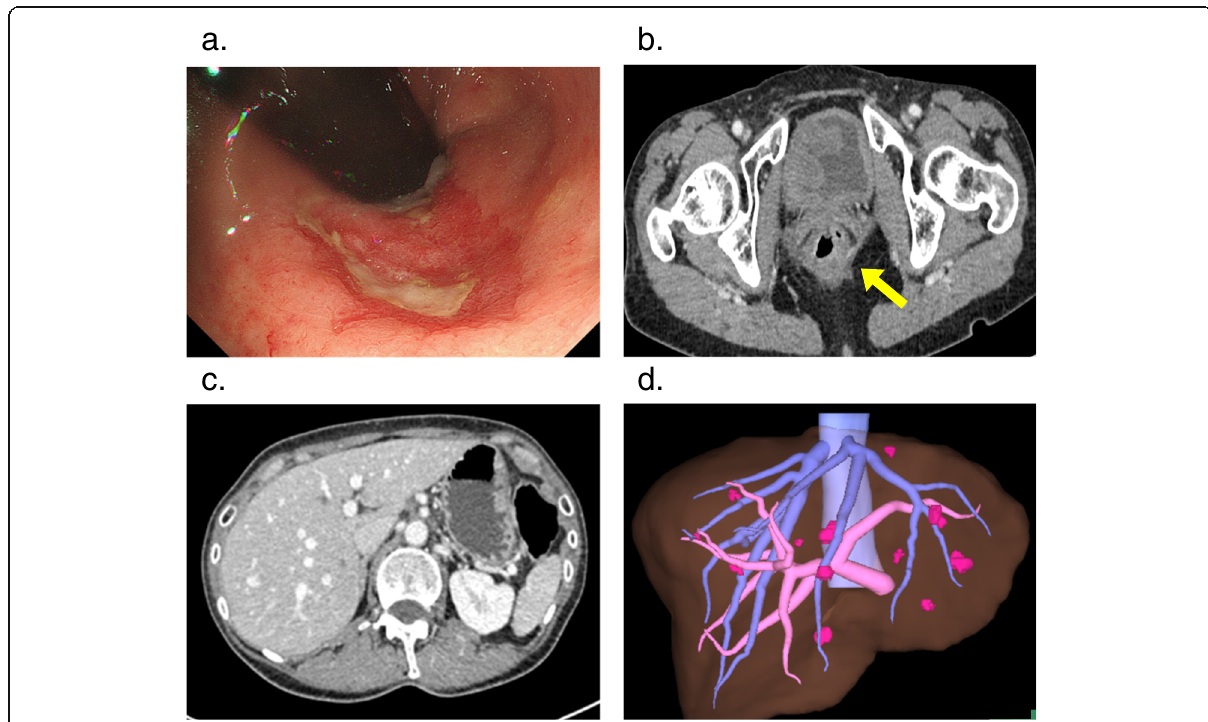
Fig. 2 CT imaging and a colonoscopy after neoadjuvant chemotherapy. a Primary rectal cancer on a colonoscopy. The rectal cancer became flat and exceedingly shrunken. b Axial view of the primary CRC (arrow) on a CT. Contrast-enhanced wall-thickening (13mm) has been improved. c Axial view of multiple bilobular liver metastases on CT. The metastatic lesions shrunk prominently. d The 3-dimensional image of the multiple bilobular liver metastases. All metastatic lesions shrunk prominently. The estimated remnant liver volume was 73.4%. CRC, colorectal cancer; CT, computed tomography